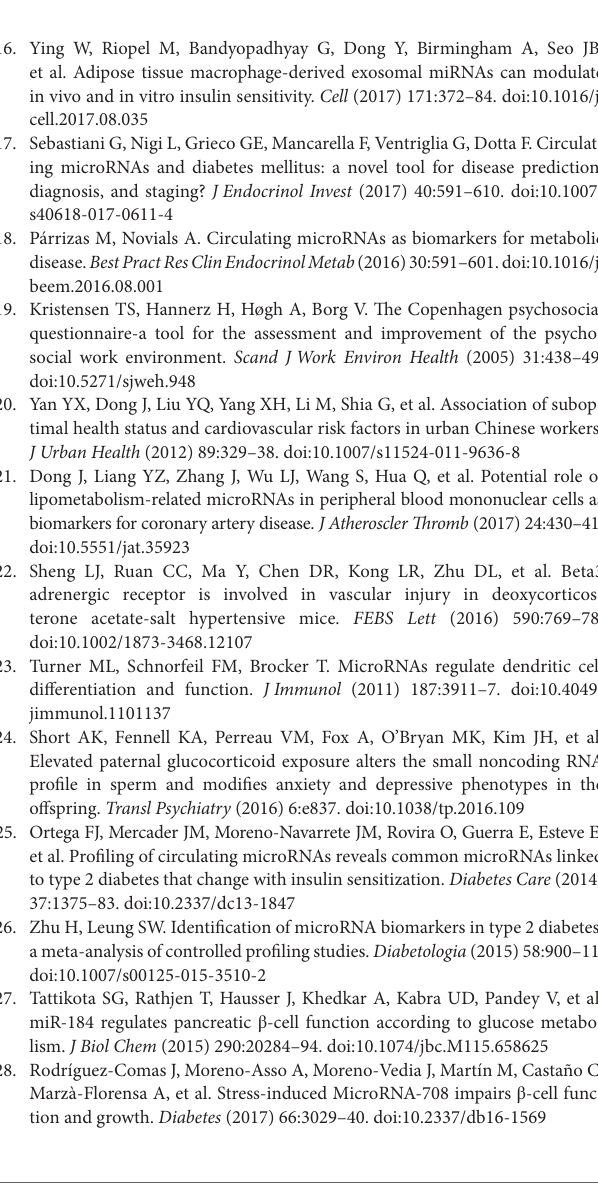
TaBle s1 | Data of differentially expressed plasma microRNAs (miRNAs) between type 2 diabetes mellitus (T2DM) patients and healthy controls in